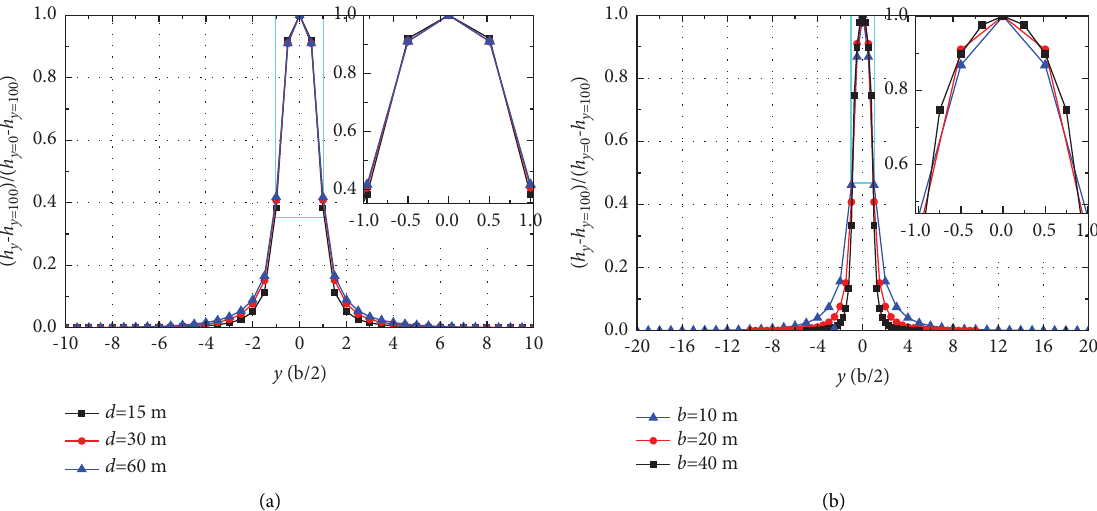
Figure 13: Lateral distribution of the WLDR at the side of the structure in homogeneous soil. (a) b � 20m, l � 10 m. (b) d � 30m, l � 10m.